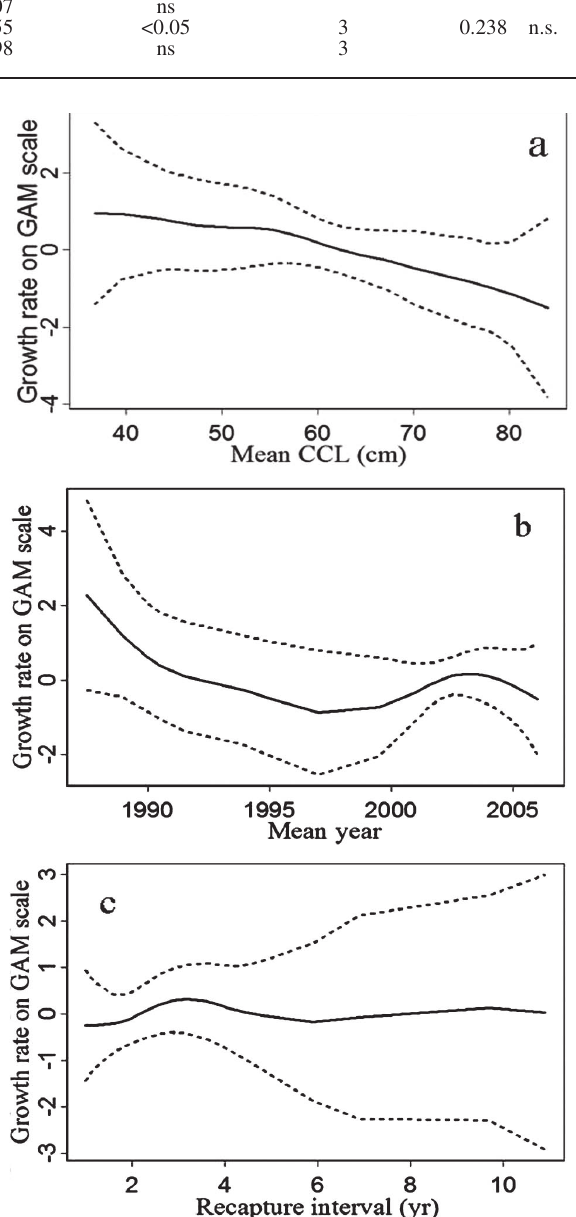
Fig . 1. – graphical summary of the gaM analysis on growth co- variates as summarised in table 1. the response variable (annual growth rate) is shown in the y-axis as a centred smooth function scale to ensure valid pointwise confidence bands (95%). Covari- ates are shown on the x-axis. (a) mean size of sizes at release and re-encounter, (b) year and (c) recapture intervals in years. solid curves indicate the cubic smoothing splines fit for each covariate conditioned on all other covariates in the gaM fit; dashed curves are pointwise 95% confidence bands around these